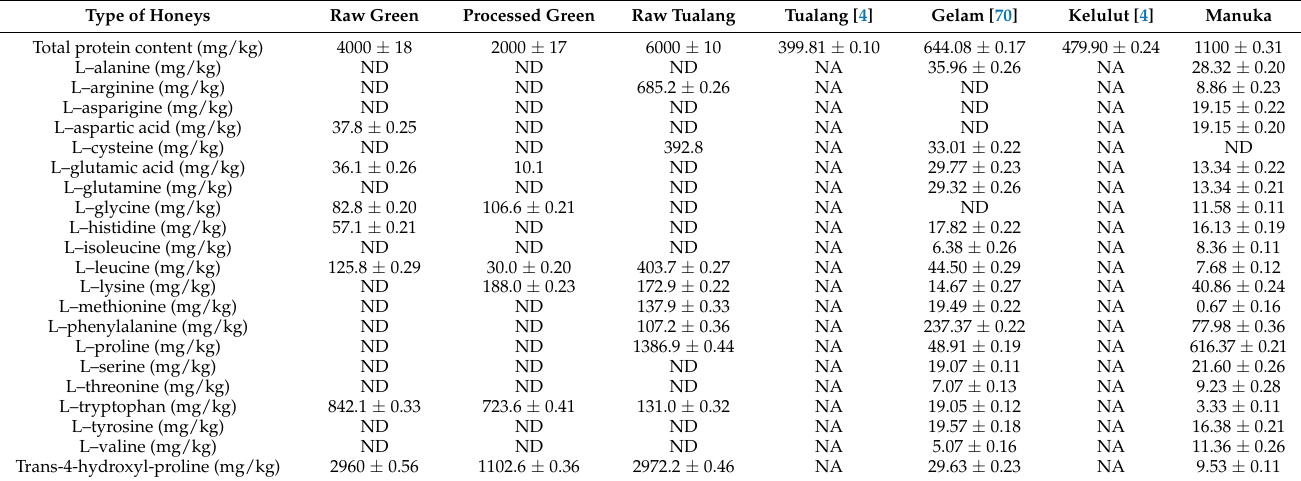
Table 3. Total protein and amino acid profiling of green honey.